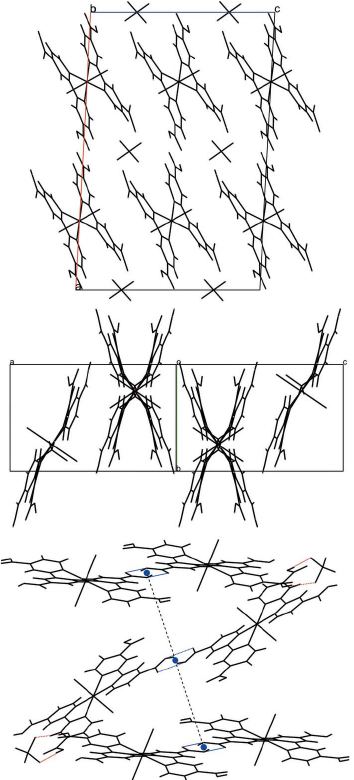
Figure 3 Crystal packing of [Ru III (dcbpy) 2 Cl 2 ]ClO 4 (top, middle), and perpendic- ular view of the layers in which the ribbons propagate (bottom).